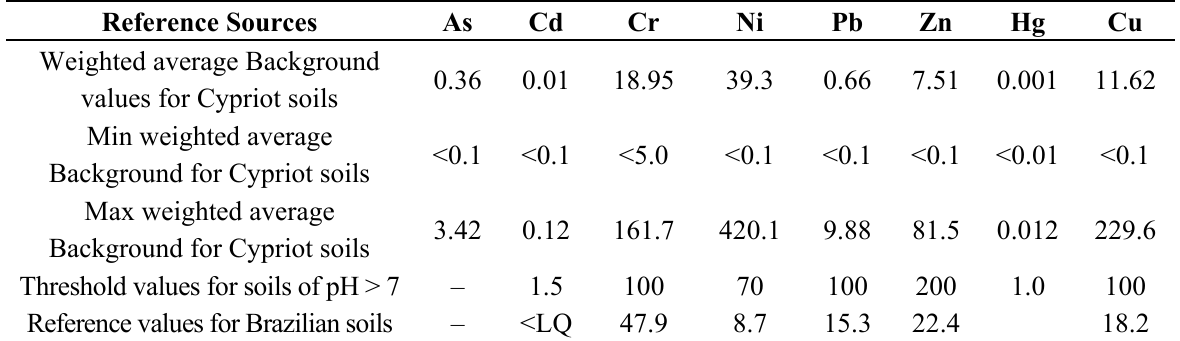
Table 2. Heavy metal reference concentrations in the various geologic units (in mg kg − 1